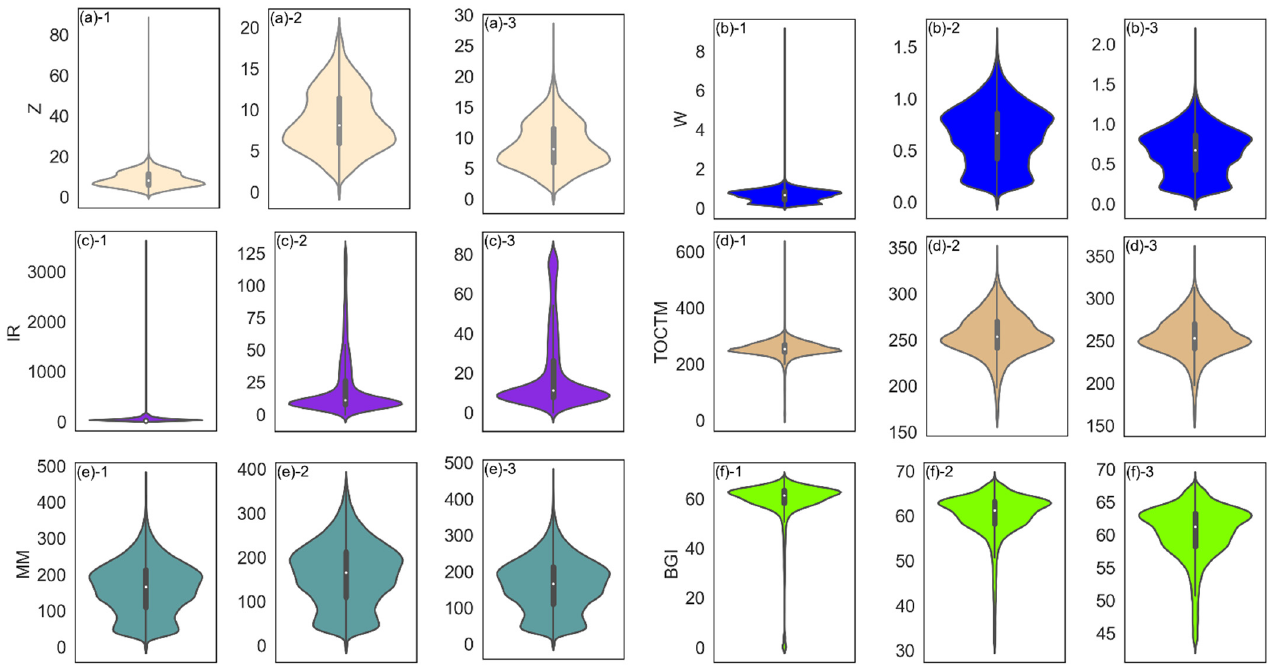
Figure 3. ( a – f ) Comparison of original data and processed data (3), i (i = 1, 2, 3) represents the data before a feature is processed, after it is processed by the box plot, and after it is processed by the 3 σ criterion, respectively.